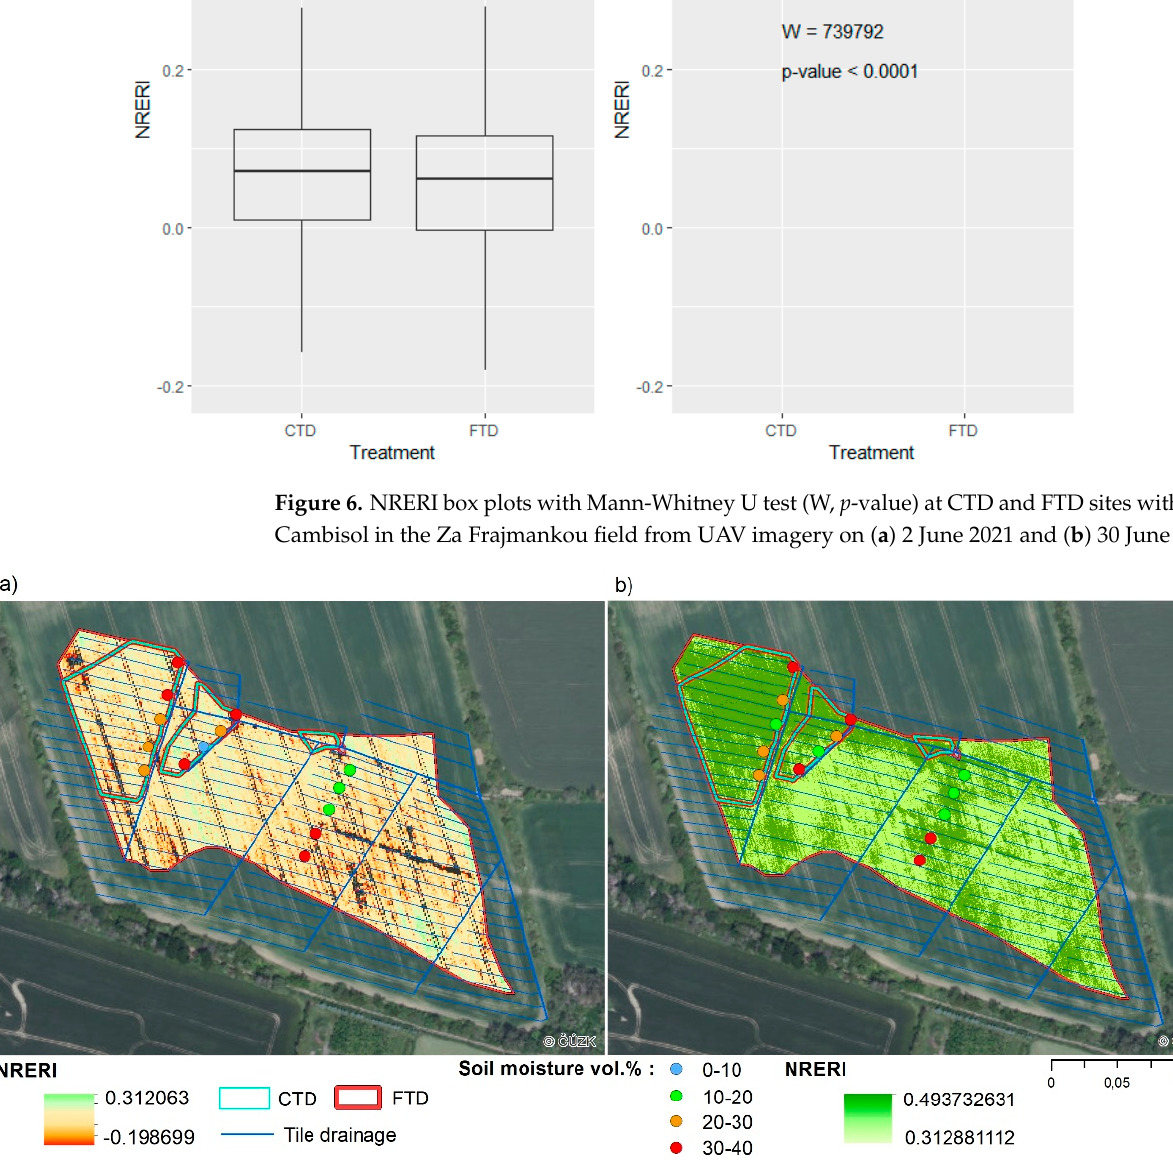
Dystric Cambisol (without headlands) of the Za Frajmankou field taken by UAV on (a) 2 June 2021